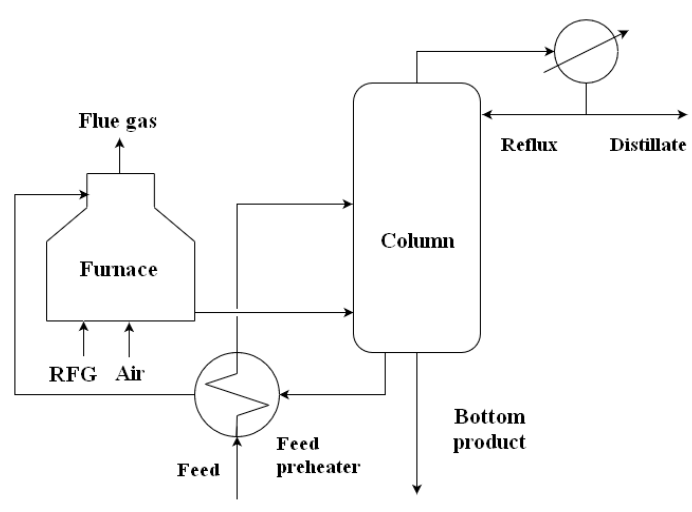
Figure 2. General flow diagram of a furnace-fired distillation column.